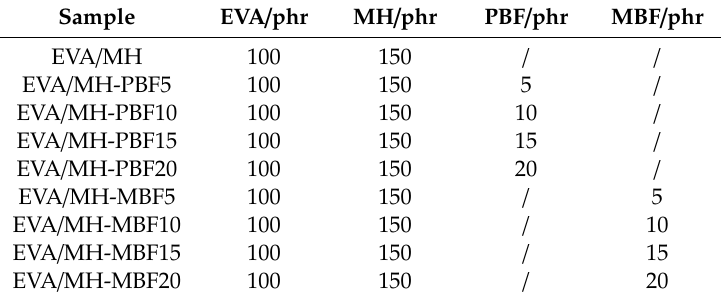
Table 1. Formulations of EVA/MH-BF Composites.